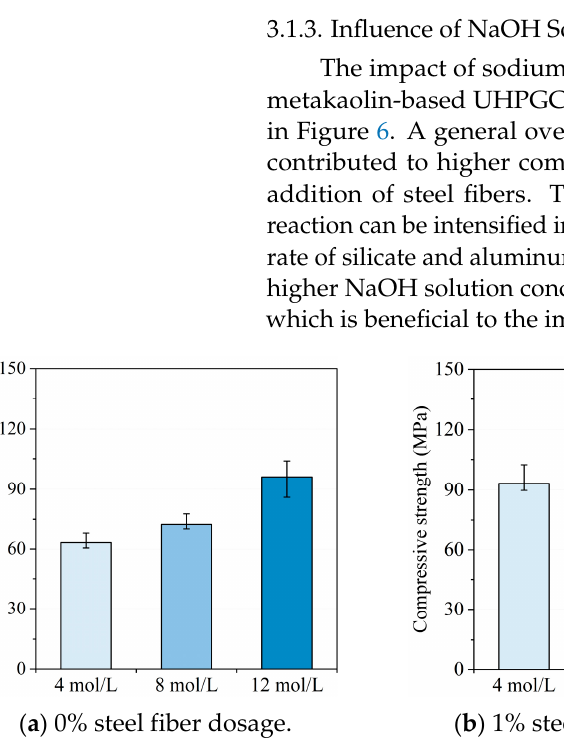
Figure 5. The influence of steel fiber dosage on compressive strength. Table 3. Average compressive strengths for each group of UHPGC. Samples